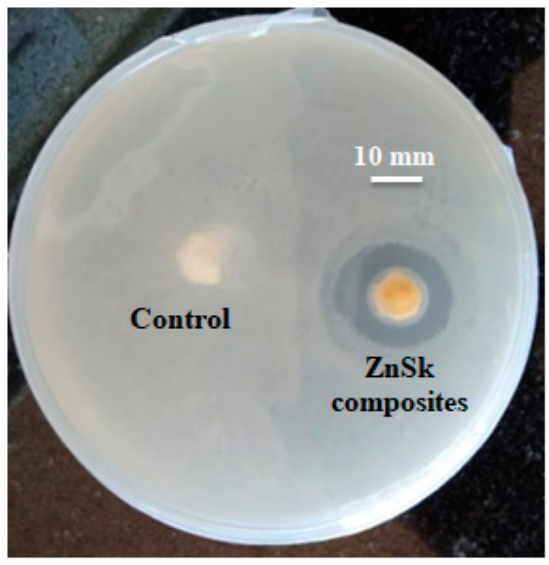
Figure 7. Zone of inhibition test showing antimicrobial effect of ZnSK composite. Degummed silk fibers are used as a control.